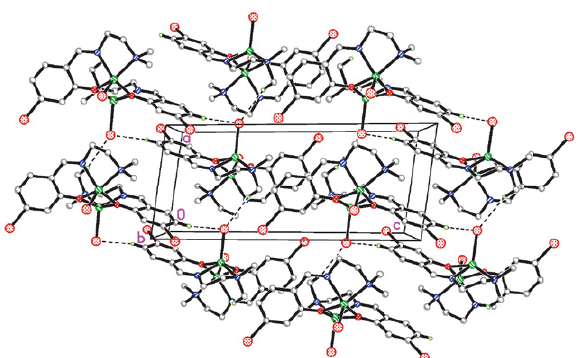
Fig. 2. Molecular packing structure of complex 1 .